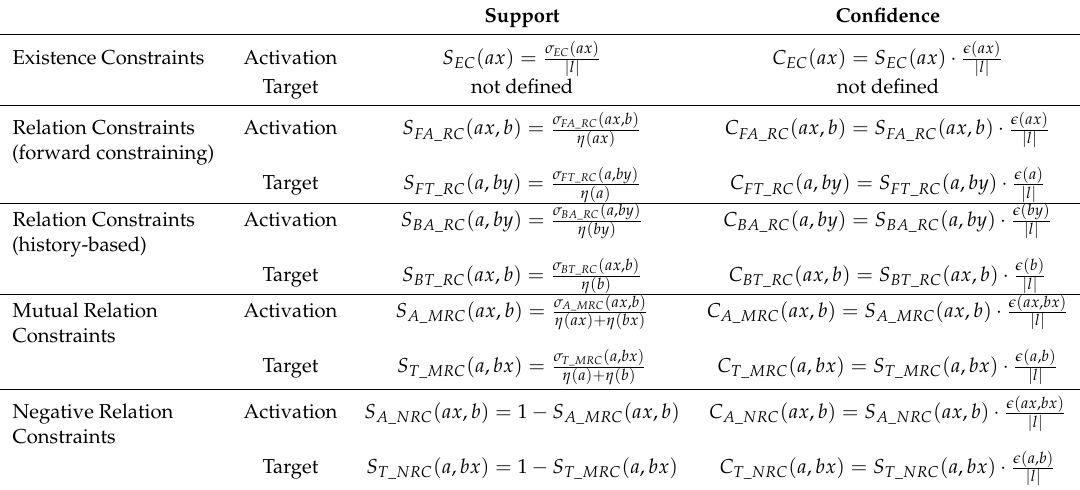
Table 20. Overview of the support and confidence equations from a multi-perspective view for all presented constraints in Table 4. The variables a and b are placeholders for events that occur in the trace, while the variables x and y refer to the resources that execute these activities. The variables (cid:101) , l , σ and η are defined in the respective